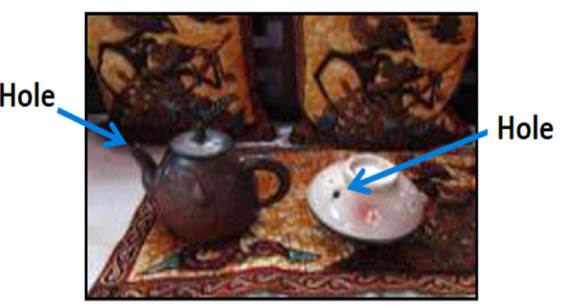
Figure 2. Earthenware for pyrolysis and ceramics ware for calcination by